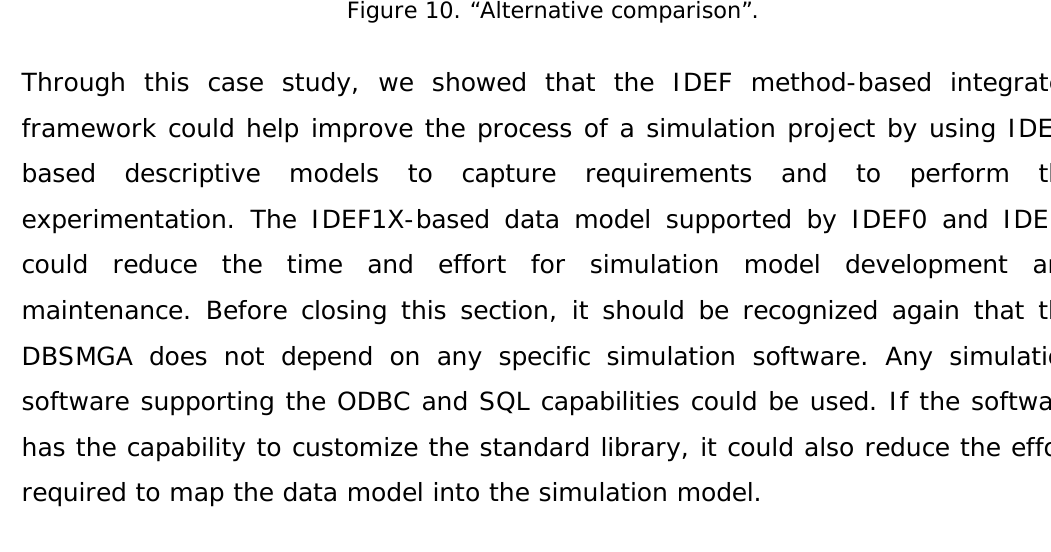
Figure 10. “Alternative